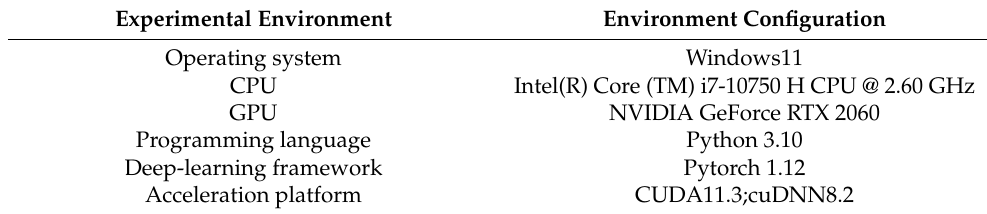
Table 2. Experimental environmental parameters.